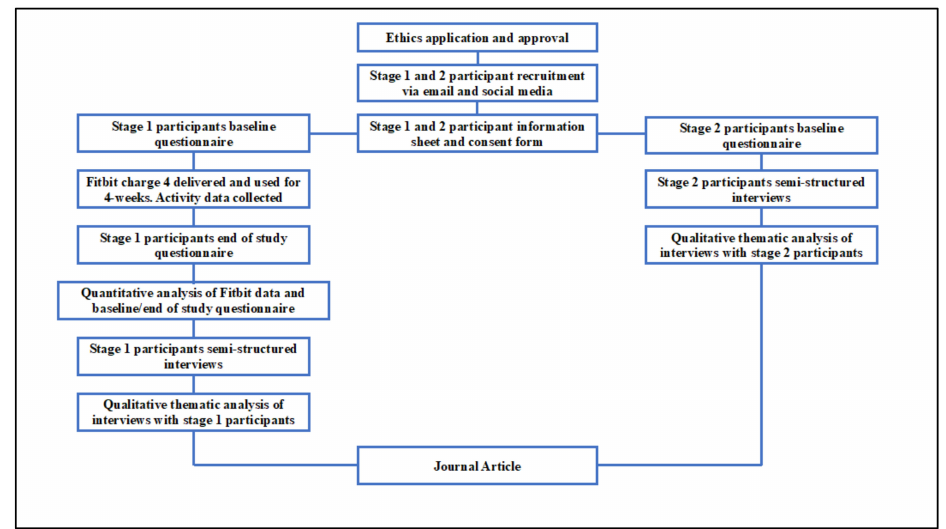
Figure 1. Flow diagram showing summary of study procedures for stage 1 and 2 participants.